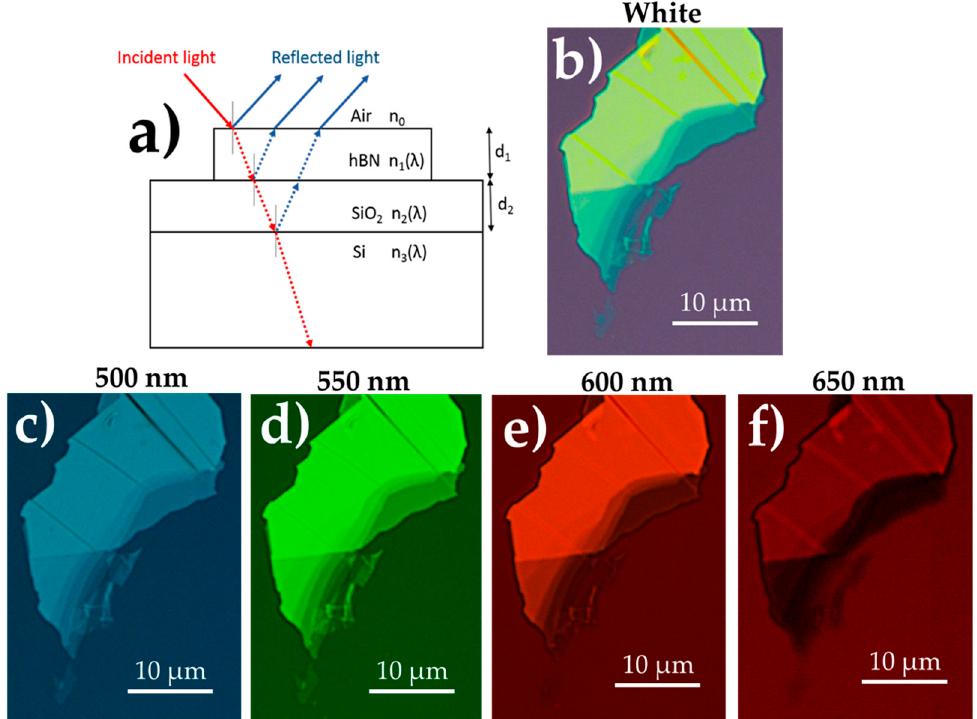
Figure 1. ( a ) Scheme of the hBN/SiO 2 /Si structure with Fresnel multiple reflections for optical contrast identification shown. The Si-substrate is considered semi-infinite with a wavelength dependent refractive index n 3 ( λ ), whereas the SiO 2 thin film will be characterized by n 2 ( λ ) and thickness d 2 . The substrate is covered by hBN microcrystals of refractive index n 1 ( λ ) and thickness d 1 , which are surrounded by air with refractive index n 0 . Optical images of the same hBN crystal are shown under ( b ) white illumination and ( c ) 500 nm, ( d ) 550 nm, ( e ) 600 nm and ( f ) 650 nm bandpass filter illumination.